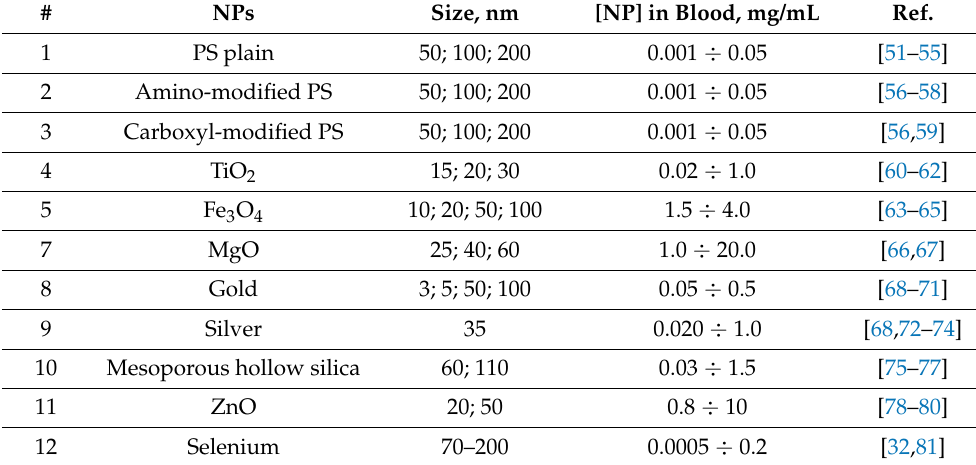
Table 1. List of NPs and their hemolytic